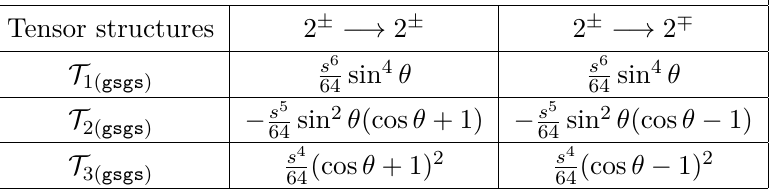
Table 9 . Angular distributions for different gsgs tensor